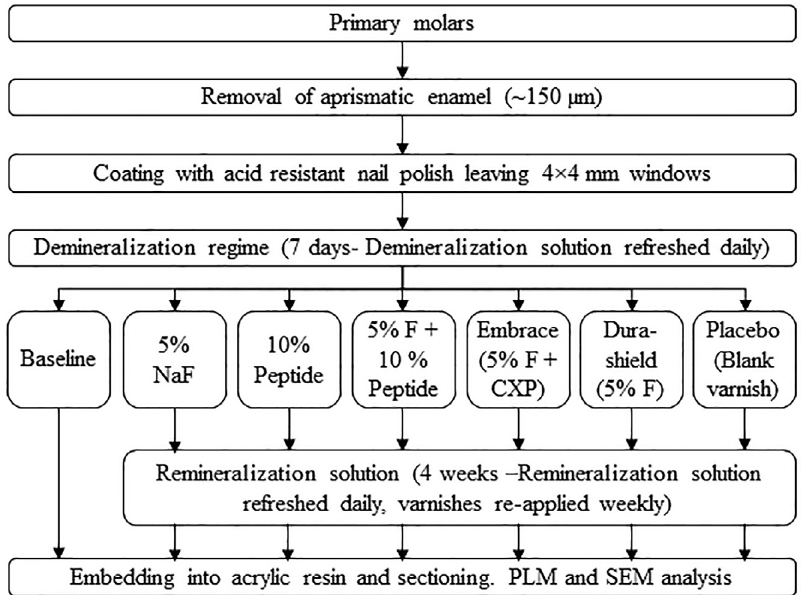
Figure 1- Outline of the study